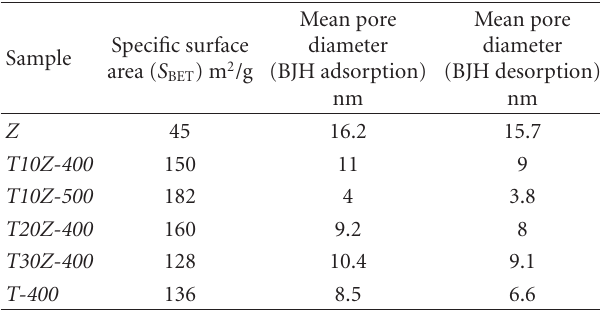
Table 2: Specific surface areas and Pore mean diameters